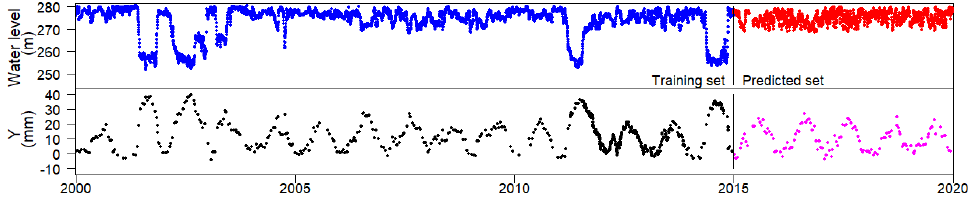
Figure 7. Radial displacements in FP3/5–277.07 m and reservoir water level along time. Table 3. Statistical parameters for the radial displacement measured in the FP3/5–277.07 m and for the reservoir water level.